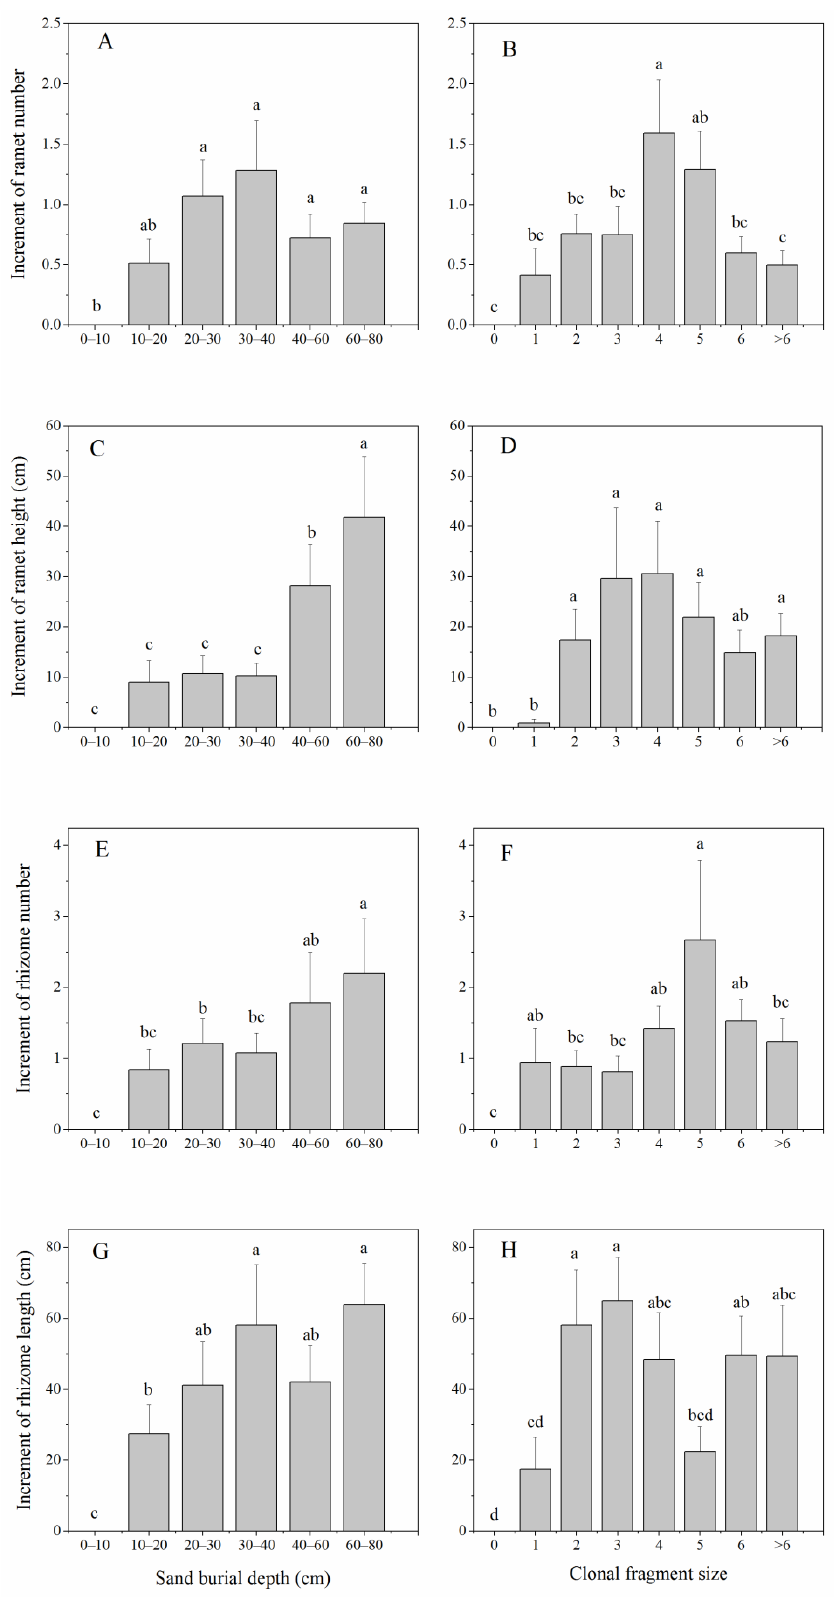
Figure 3. The effects of sand burial depth and clonal fragment size on the number of newly produced ramets ( A , B ), the increment in ramet height ( C , D ), the number of newly produced rhizomes ( E , F ) and the increment in rhizome length ( G , H ) of P. communis . Different letters indicate significant differences in biomass among different sand burial depths and/or clonal fragment sizes at the p < 0.05